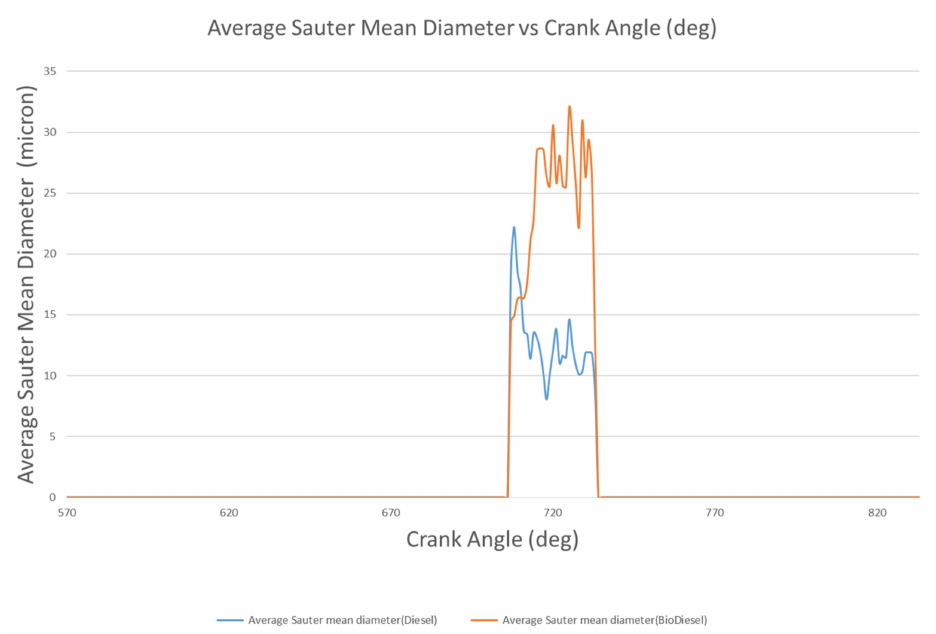
Figure 10. Sauter mean diameter vs. crank